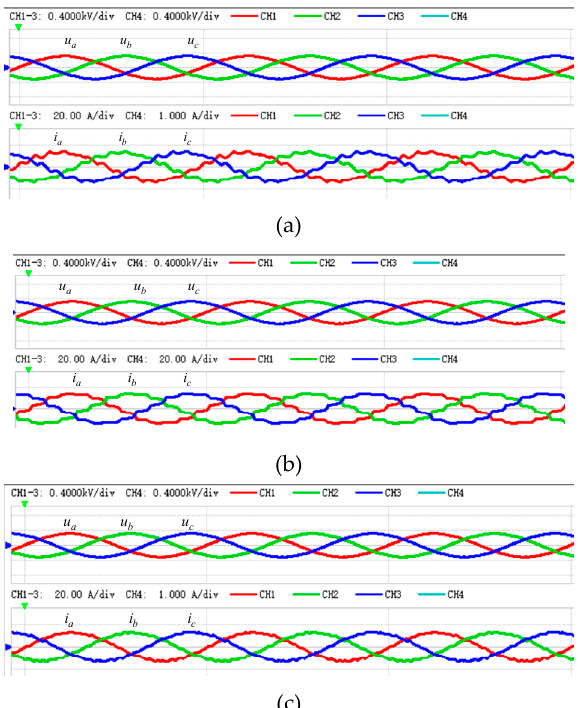
Figure 10. Voltage and current measured waveform at the 380 V bus. ( a ) Without filter, ( b ) the PF method, ( c ) the IF method.